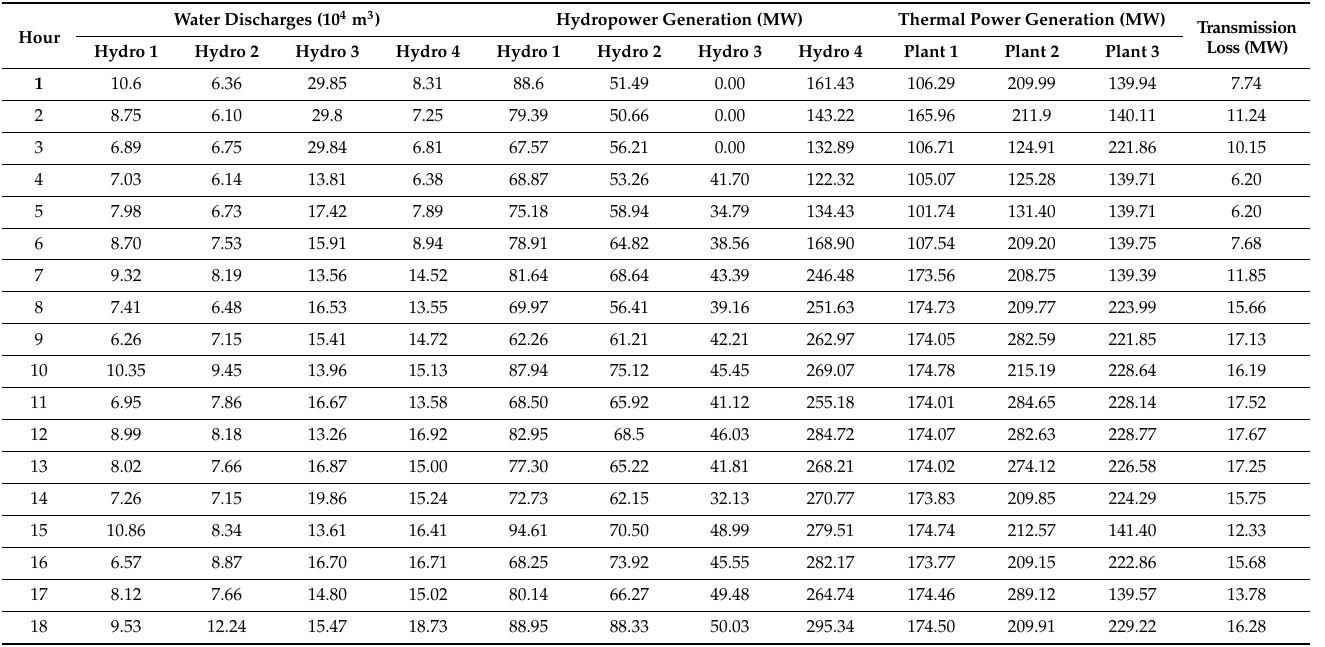
Table 10. Optimal MSHTS results with NSDOGSA for Test